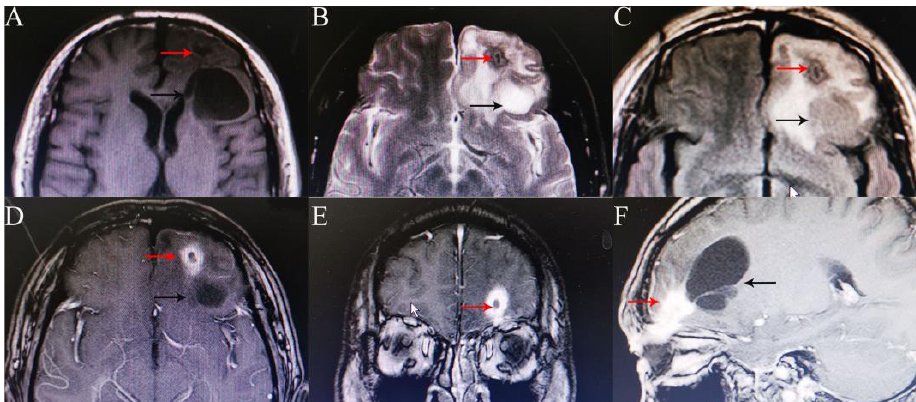
Figure 3. Head magnetic resonance imaging (MRI) showed a strip-shaped lesion that stretched from the left orbital roof to the left frontal lobe, was isointense on the T1-weighted image, slightly hyperintense on the T2-weighted image, and isointense/hypointense on FLARE ( A – C red arrow), with obvious irregular enhancement surrounding it ( D – F red arrow), and a 3.9 × 3.4 × 4.9 cm cystic shadow behind the lesion (black arrow).